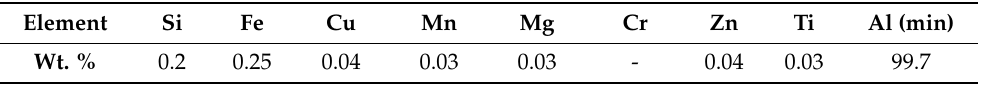
Table 3. Elemental composition of the aluminum alloy (Alloy-1070) used to fabricate the electrodes. The values indicate the maximum limits unless indicated as